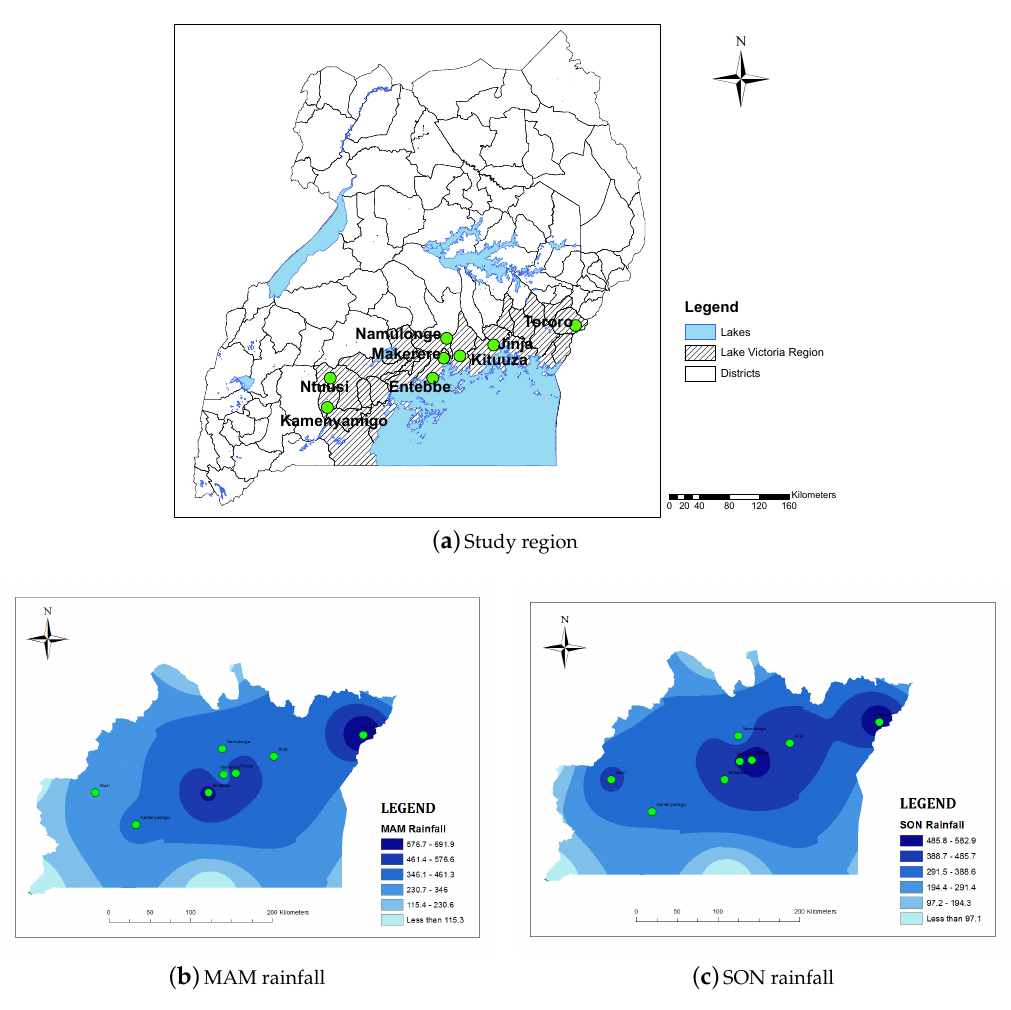
Figure 1. ( a ) The map of Uganda and the study region; ( b ) average Lake Victoria Basin (LVB) MAM seasonal rainfall; and ( c ) the average LVB SON seasonal